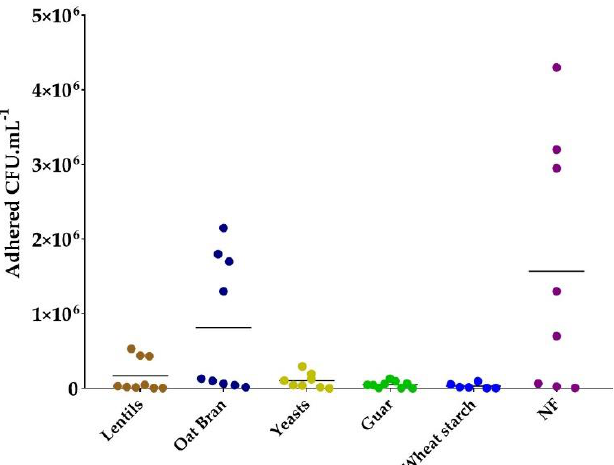
Figure 4. Modulation of ETEC adhesion to co-culture of Caco-2/HT29-MTX cells by fiber-containing products. Fiber-containing products were tested at 2 g · L − 1 of final fiber content. Each biological replicate and their mean are represented ( n = 6–9). Results are expressed as adhered CFU · mL − 1 of cellular lysate. No significance with the control condition was found according to Tukey’s multiple comparison tests. NF = control condition with no product